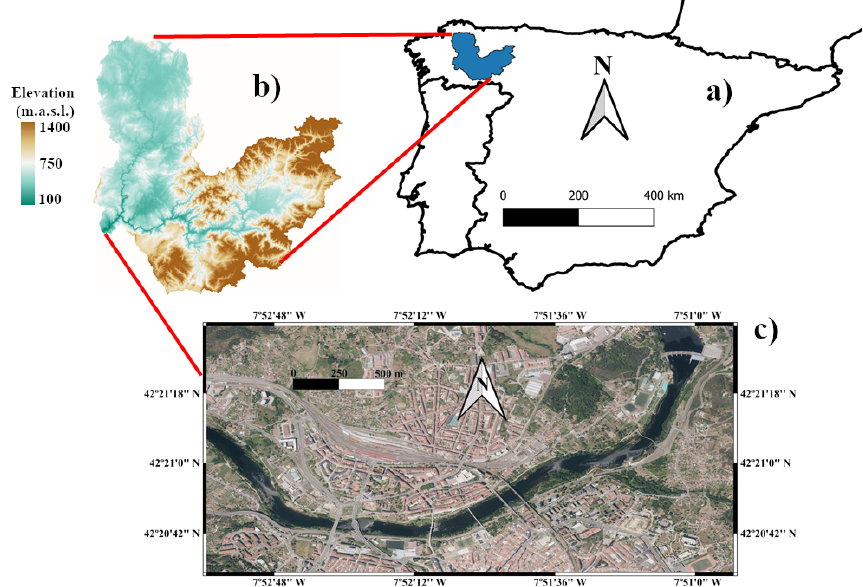
Figure 1. (a) Location of the Miño-Sil basin upstream of Ourense city. (b) Map of elevations of the catchment under the scope. The channel that flows from north to south represents the Miño river and the channel that flows from east to west its main tributary, the Sil river. (c) Area of study in Ourense city (PNOA courtesy of © Instituto Geográfico Nacional).